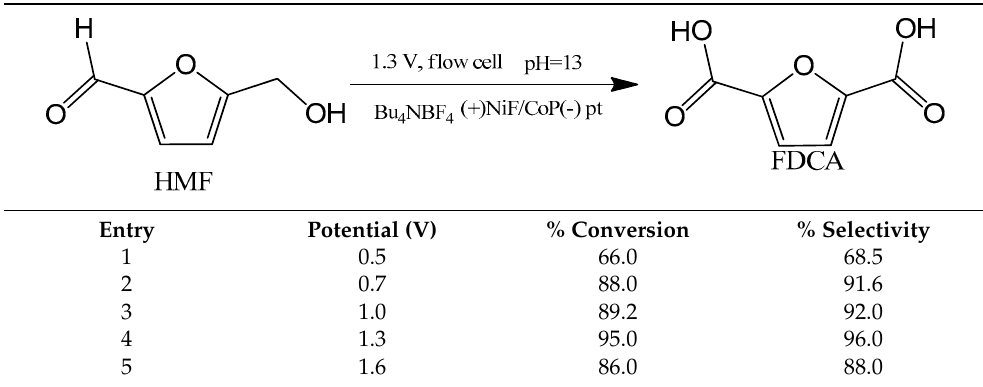
Table 3. Optimization of droplet assisted electrochemical oxidation of HMF *.